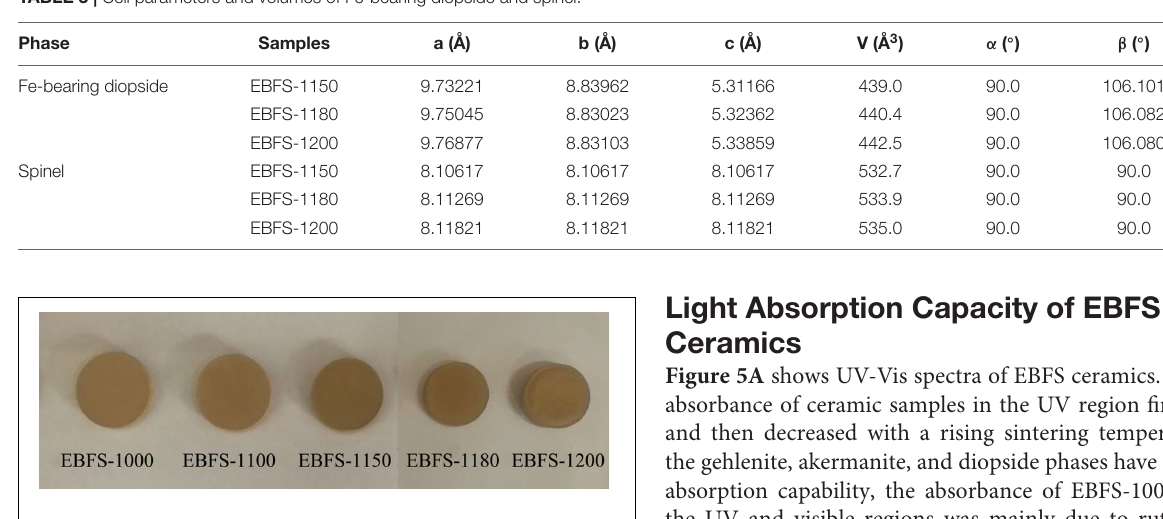
FIGURE 2 | Appearance of EBFS